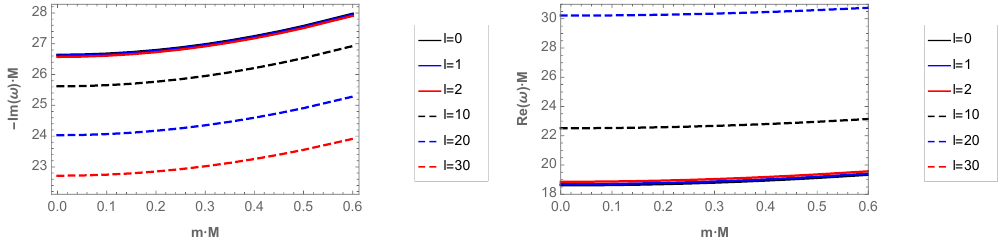
Figure 5 . The behaviour of fundamental mode (cid:0) Im ( ! ) M (left (cid:12)gure) and Re ( ! ) M (right (cid:12)gure) as a function of mM for di(cid:11)erent values of the parameter ‘ = 0 ; 1 ; 2 ; 10 ; 20 ; 30, with M 2 (cid:3) = (cid:0) 765075.